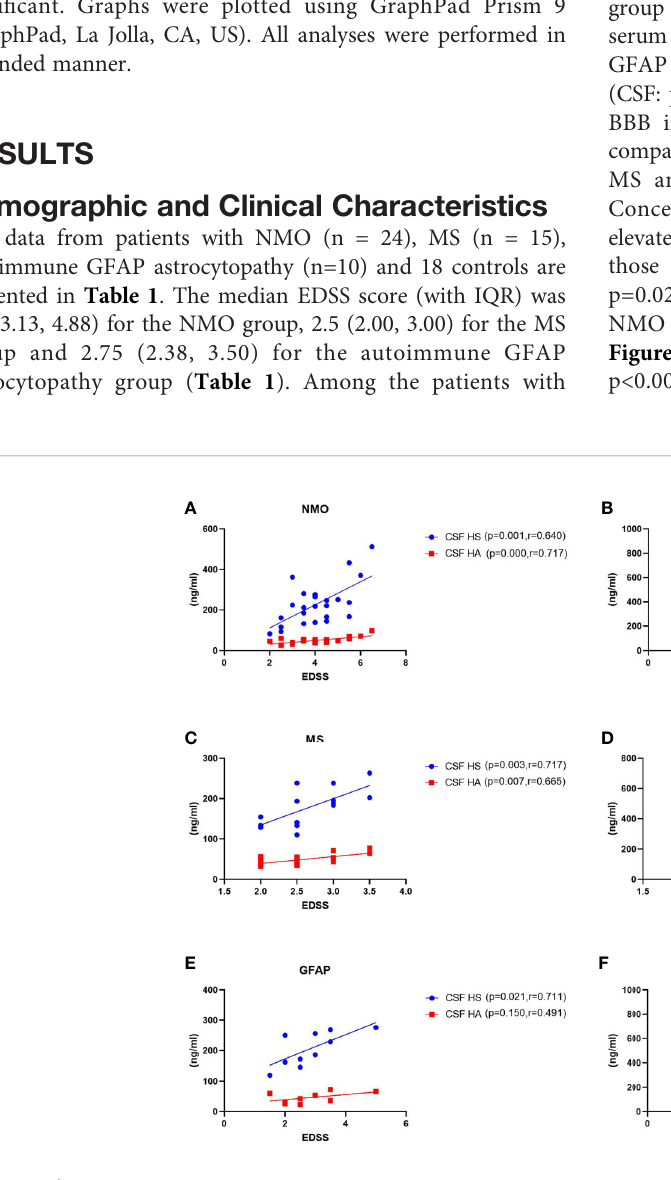
FIGURE 2 | Correlations between levels of CSF and plasma HS and HA and EDSS scores in patients with NMO, MS and GFAP encephalitis. (A – B) In NMO, the CSF and plasma levels of HS and HA were positively correlated with EDSS scores. (C – D) In MS, the levels of HS and HA in CSF were signi fi cantly correlated with EDSS scores, while no correlations were found between plasma HS or HA levels and EDSS scores. (E – F) In autoimmune GFAP astrocytopathy, the CSF and plasma levels of HS were signi fi cantly correlated with EDSS scores, while no correlations were found between CSF and plasma HA levels and EDSS scores. The p and r-values are indicated within each